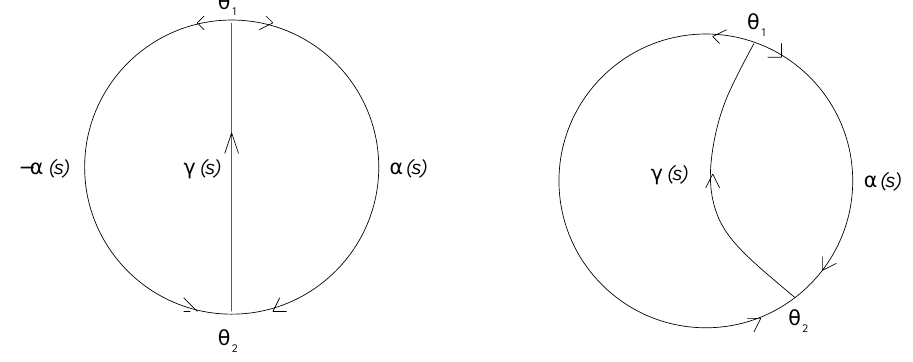
Fig. 1 – Symmetric and nonsymmetric infinite heteroclinic cycles of a planar polynomial vector field on the Poincaré disk (after